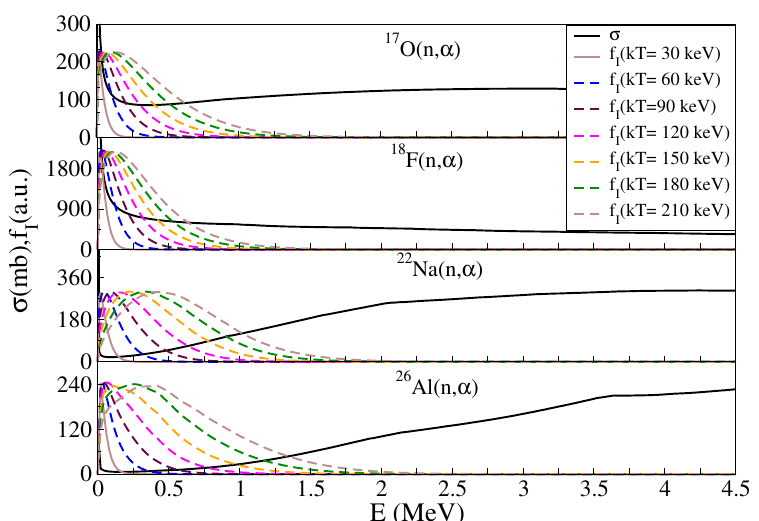
Figure 7. Relevant ( n , α ) reaction energy windows for the range of temperatures kT = 30–210 keV described with the function f I ( E ) (in arbitrary units, see text) and the respective reaction cross sections for 17 O, 18 F, 22 Na, and 26 Al target nuclei.